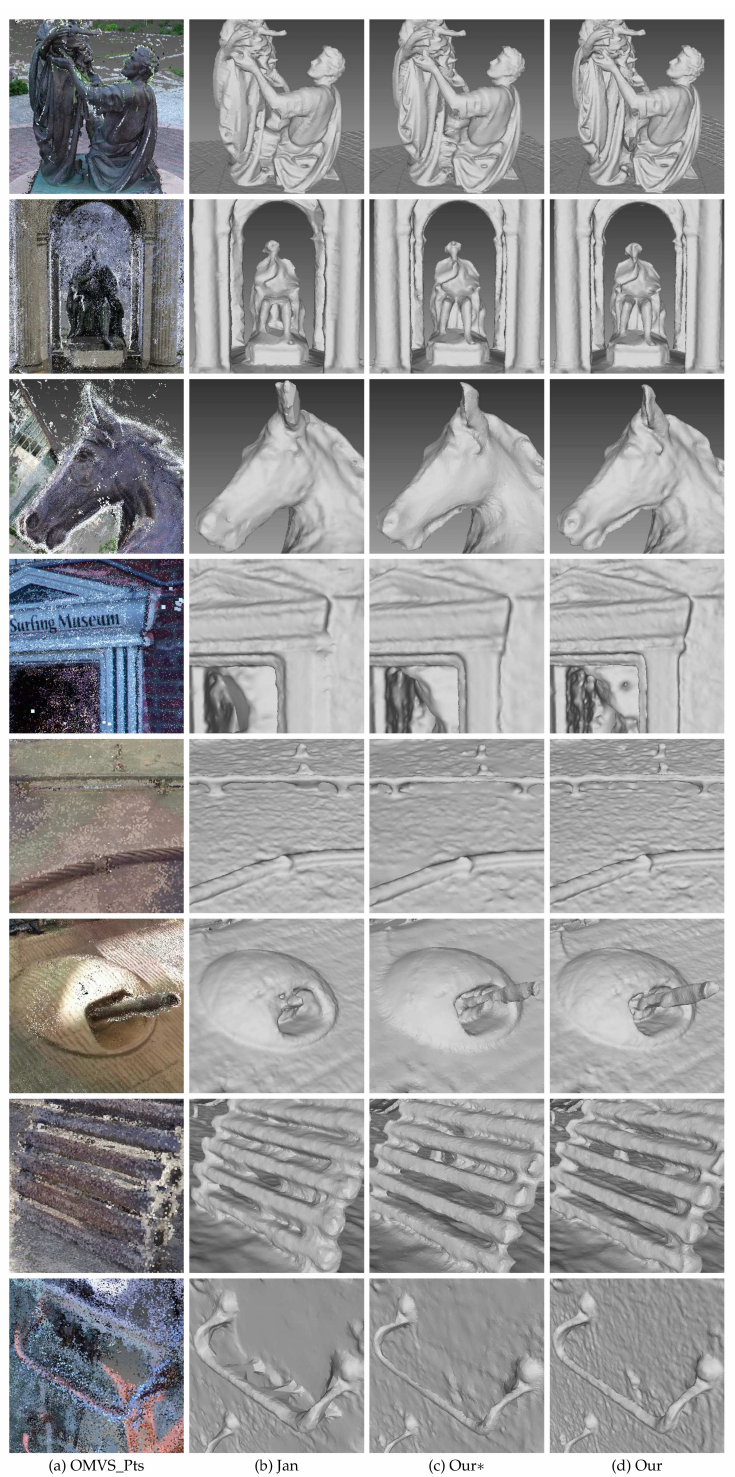
Figure 15. Detailed views of three methods on the intermediate set of Tanks and Temples dataset [40]. From top to bottom are Family, Francis, Horse, Lighthouse, M60, Panther, Playground and Train. From left to right are: ( a ) the point cloud generated by OpenMVS; ( b ) the mesh of Jancosek and Pajdla [5]; ( c ) the mesh of the proposed method without the dense visibility technique; and ( d ) the mesh of the proposed